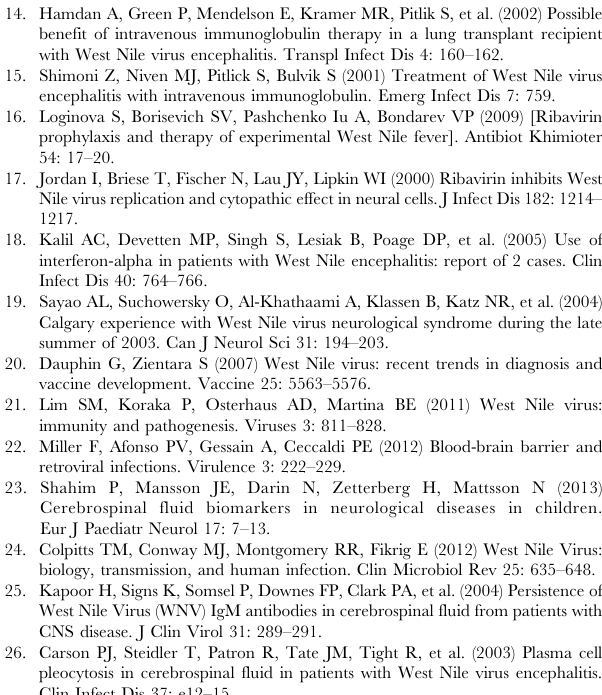
Table S1 Experimental design for iTRAQ reagent- labeling of CSF sample pools. Thirty microgram of each pooled group; C2 group (pool-AH1 to AH3), C3 group (pool-IIH1 to IIH2) or WNND, A2 group (poolW1 to W3) were digested with trypsin and the resulting peptides of each sample were specifically labeled with one iTRAQ reagent as indicated below, previously to mix all samples. WNND, West Nile neuroinvasive disease; AH, acute headache; IIH, idiopathic intracranial hypertension; CSF, cerebrospinal